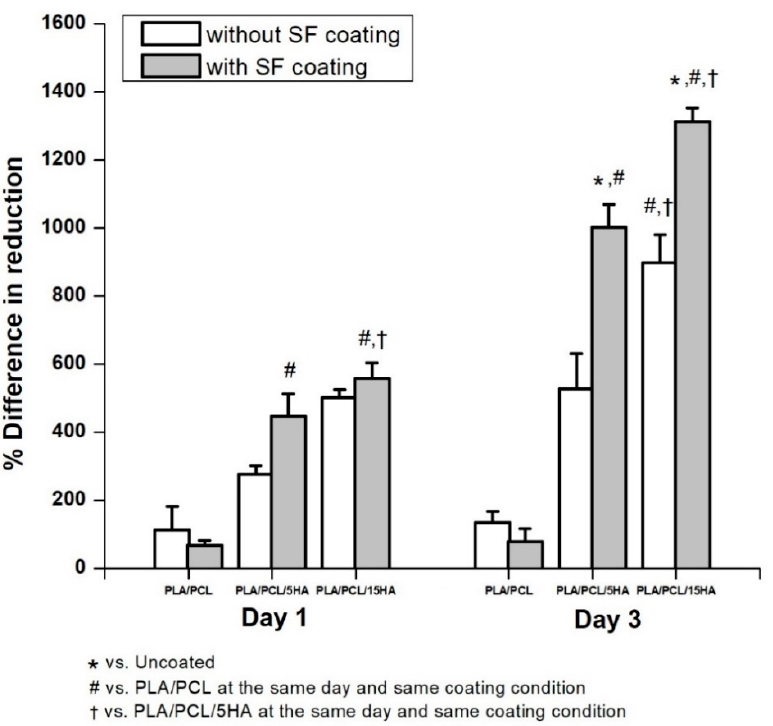
Figure 13. E ff ect of human fetal osteoblast cell proliferation, without a SF coating and with a SF coating .